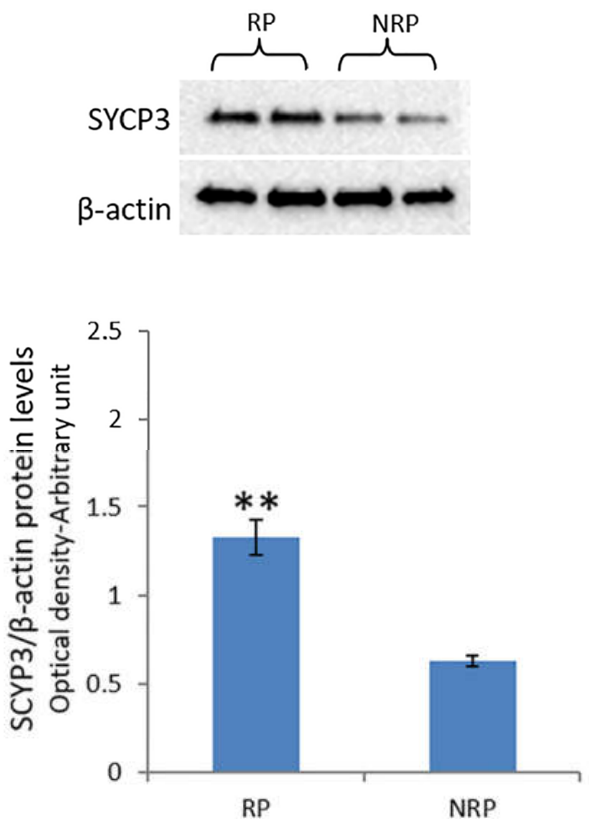
Figure 4. Western blot detections for SYCP3 in quail testis during reproductive and non-reproductive periods. A specific band of 33 kDa was detected. The amount of protein was quantified using the ImageJ program and normalized with respect to β -actin protein. The values presented represent the means ± S.D. of the values obtained for five animals (two bands were shown). ** p < 0.01 for reproductive period vs. non-reproductive period. RP, reproductive period; NRP, non-reproductive period.